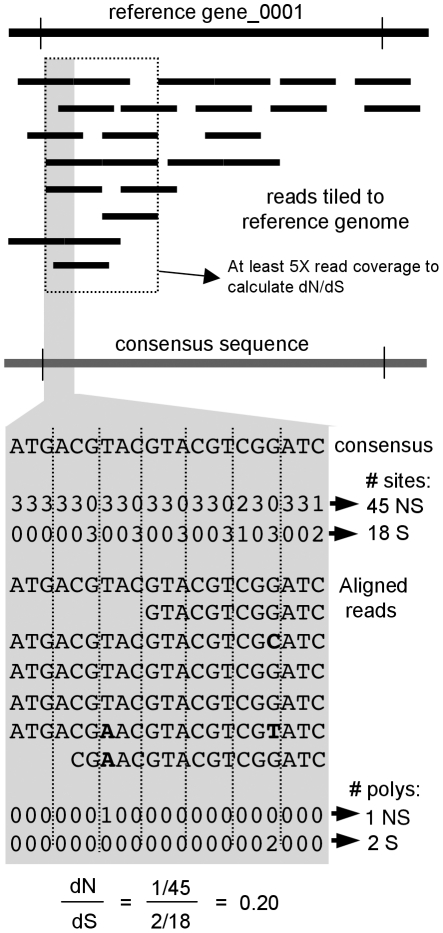
Schematic of environmental metagenome tiling and dN/dS calculation.Sequence reads were tiled to a reference genome. A majority-rule consensus sequence was generated from the aligned reads. The number of non-synonymous (NS) and synonymous (S) sites were calculated from the consensus sequence. The observed NS and S polymorphisms (polys) in the aligned reads relative to the consensus sequence are shown in bold. An example of aligned reads and dN/dS calculation is shown for a small section of a gene, but the same methodology would be used for an entire gene.